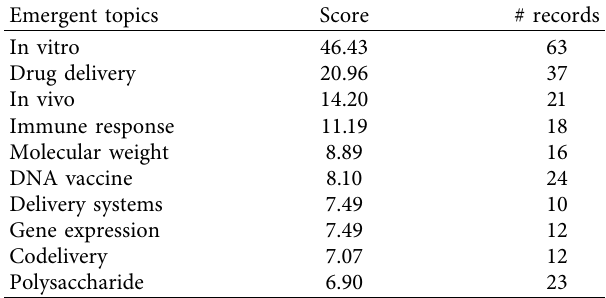
Table 3: Terms with the top 10 emergence